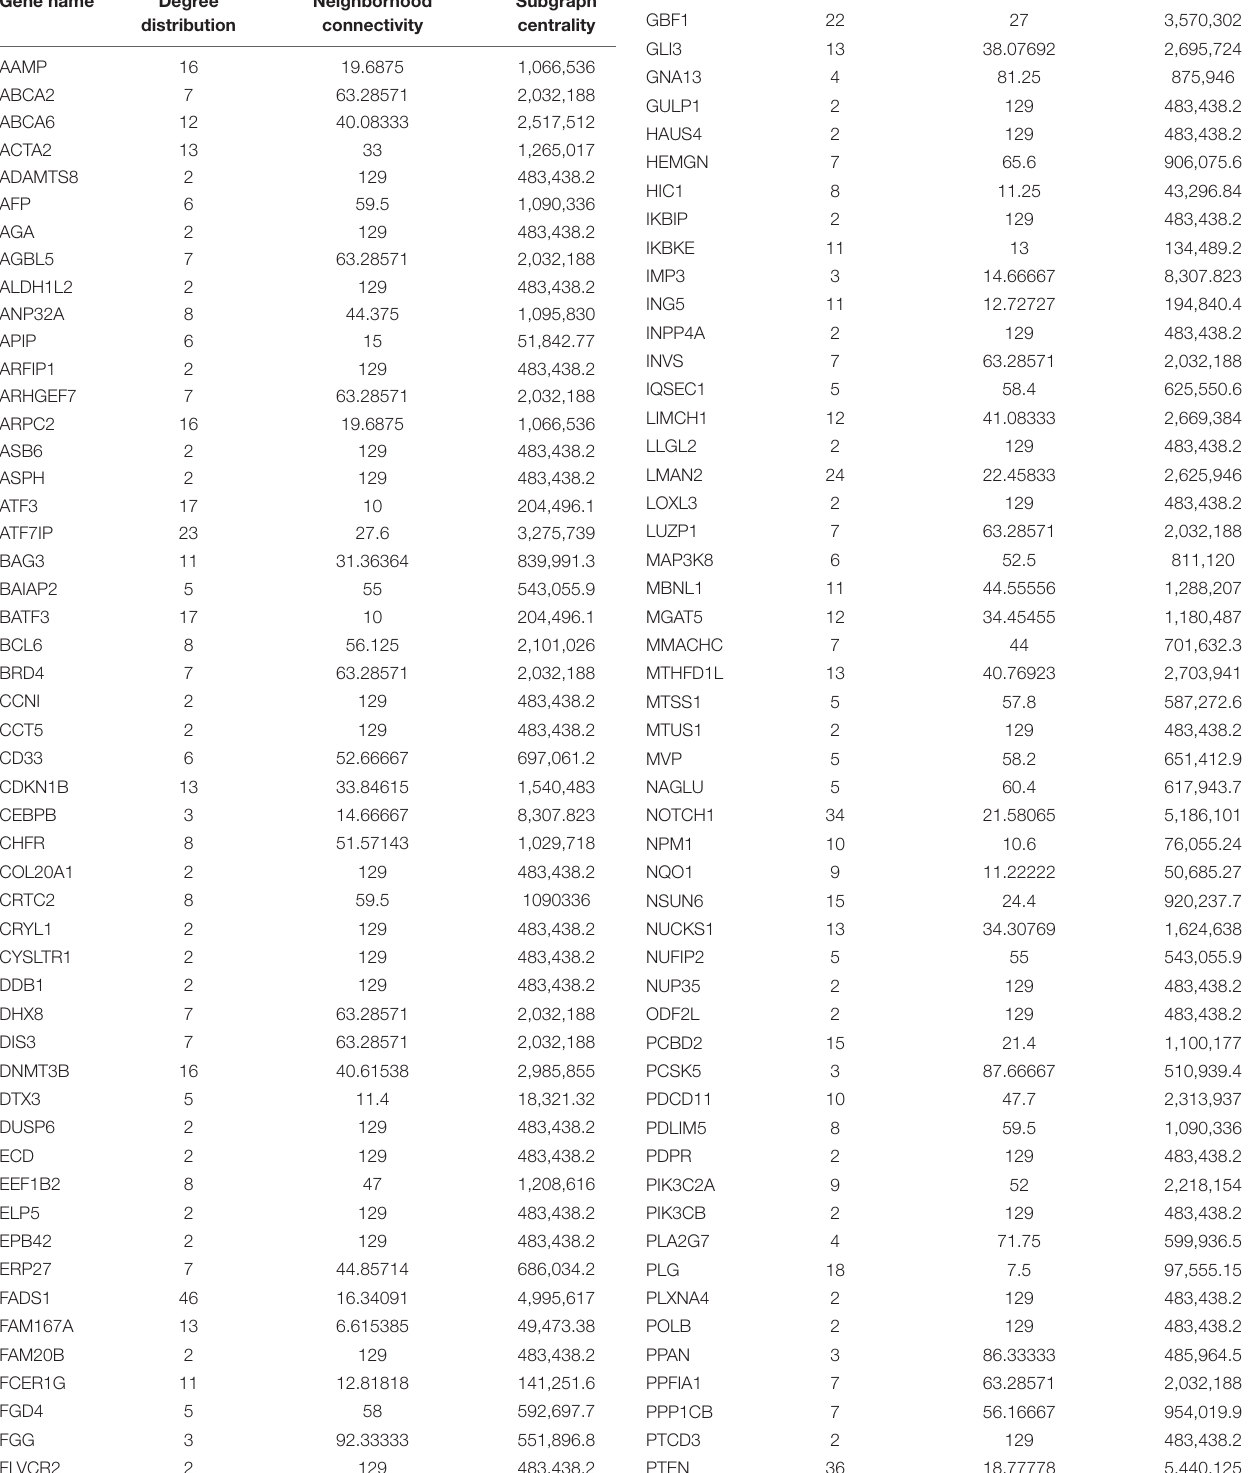
TABLE 1 | Maximally regulated genes for muscle atrophy from the spaceflight Genelab datasets GLDS-4, GLDS-244, GLDS-245, GLDS-246, GLDS-288, and GLDS-289 selected by Markov Blanket network